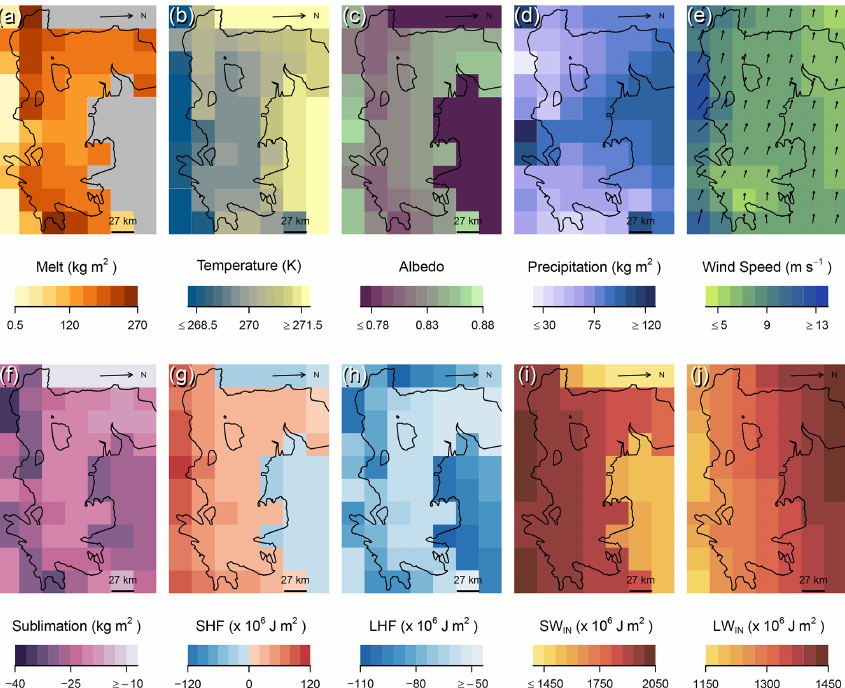
Figure 7. Average summer (DJ) values from RACMO2.3p3, for the Shackleton Ice Shelf (2002/03–2017/18). Panels (a) , (d) , and (f–j) show the average cumulative summer value; (b–c) and (e) are the average value across all summers. Panels (g) – (j) respectively show sensible heat flux (SHF), latent heat flux (LHF), incoming shortwave radiation (SW), and incoming longwave radiation